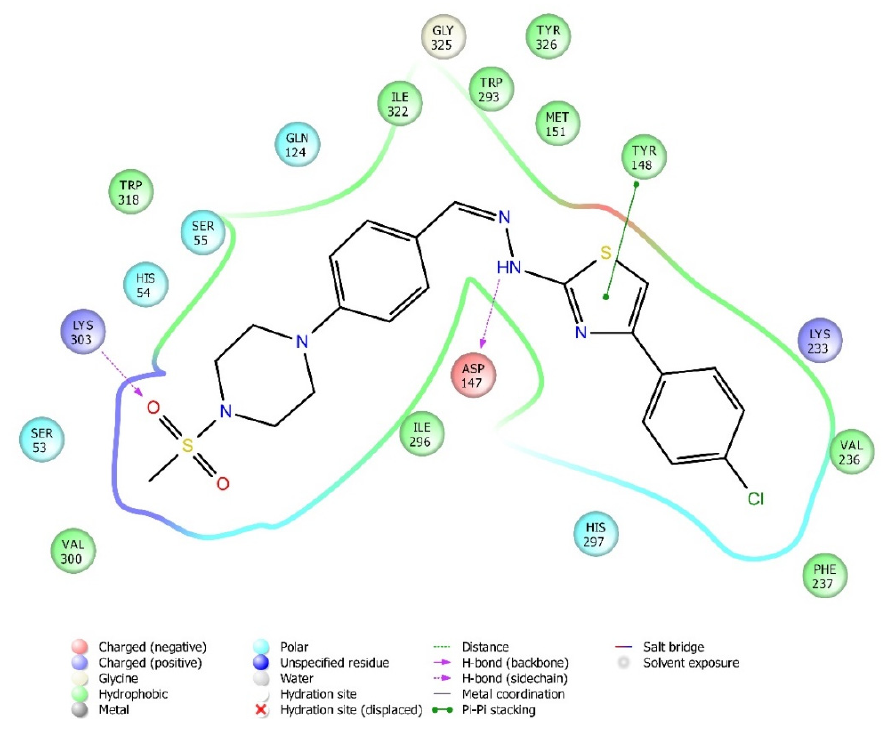
Figure 13. The two-dimensional interacting mode of compound 3g in the active region of µ-opioid receptor (PDB Code: 5C1M).